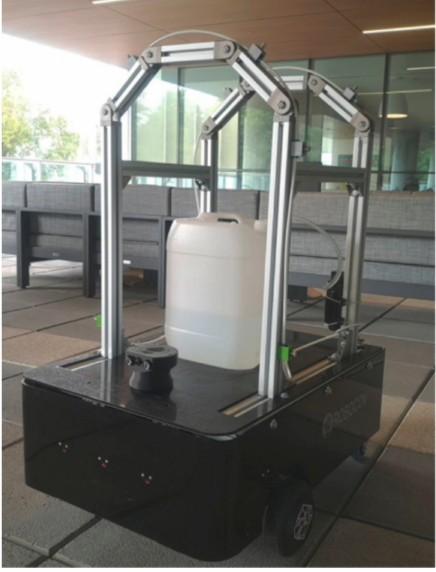
Figure 28. Operating atomizer disinfection module working on open spaces.